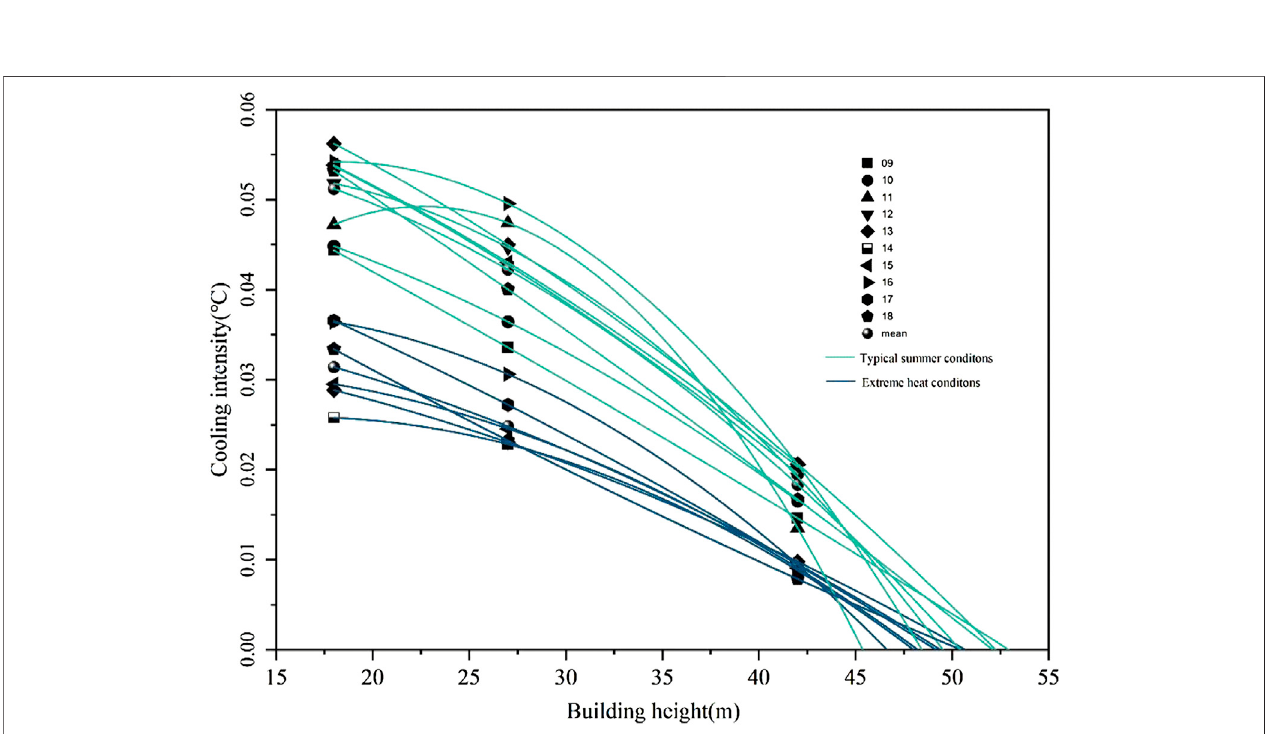
Frontiers in Environmental Science |